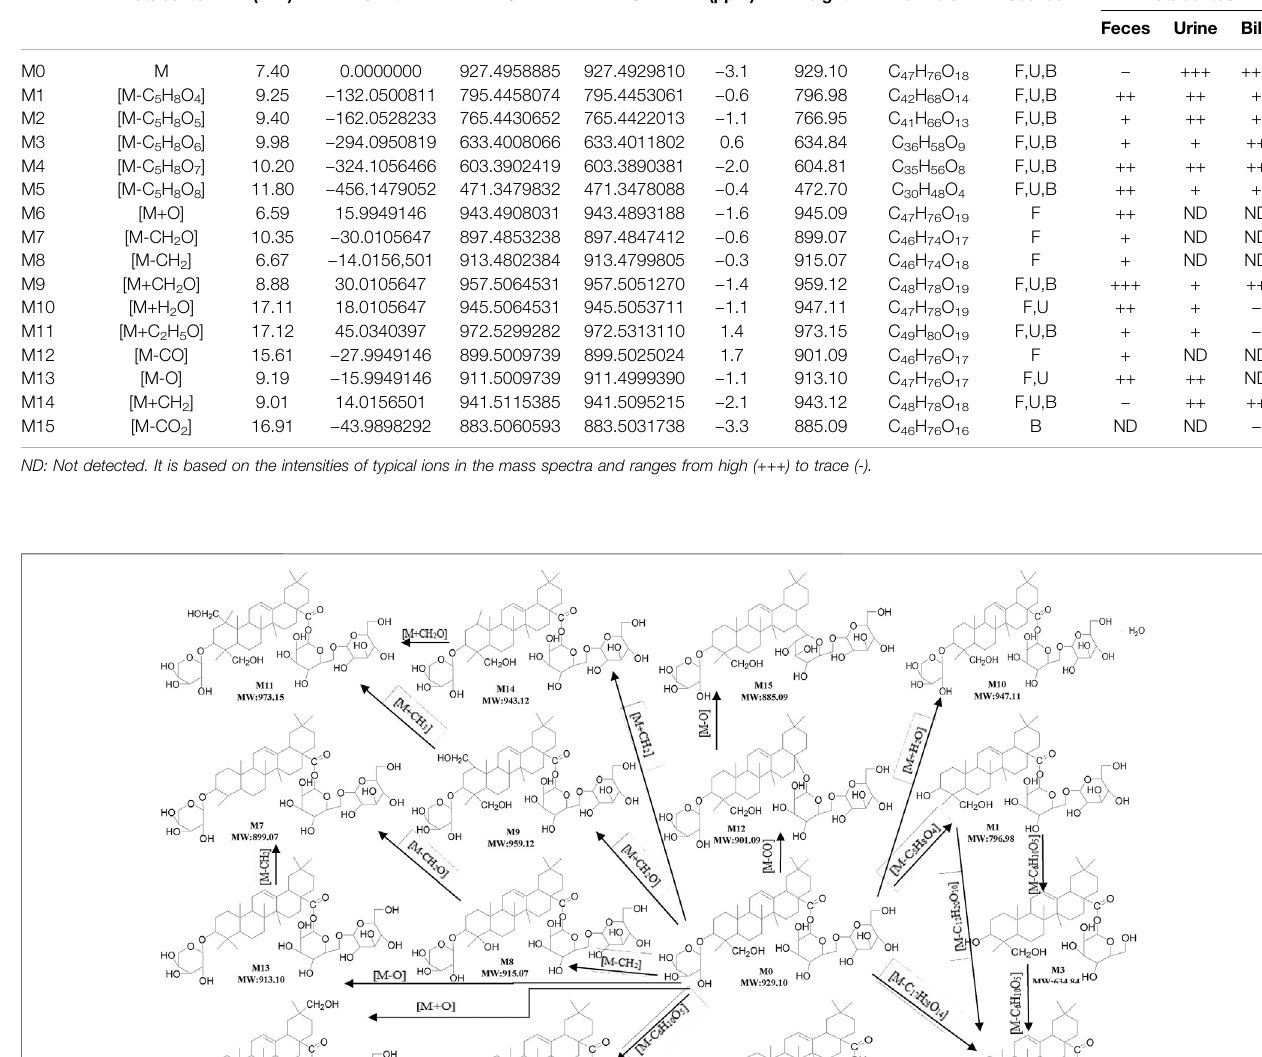
TABLE 4 | Characterized metabolites in rat feces, urine and bile following intravenous injection of ASD at dosage of 10 mg/kg by UHPLC-Q-Exactive-Orbitrap-MS. Peak Putative ID metabolite